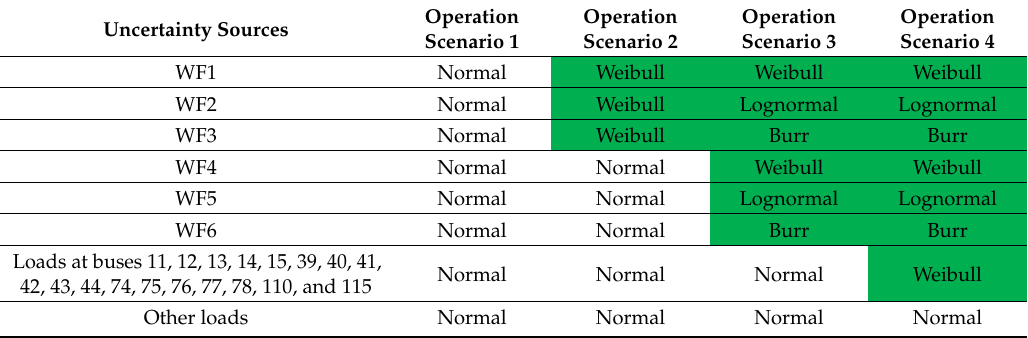
Table 4. The operation scenarios of hybrid AC/VSC-MTDC